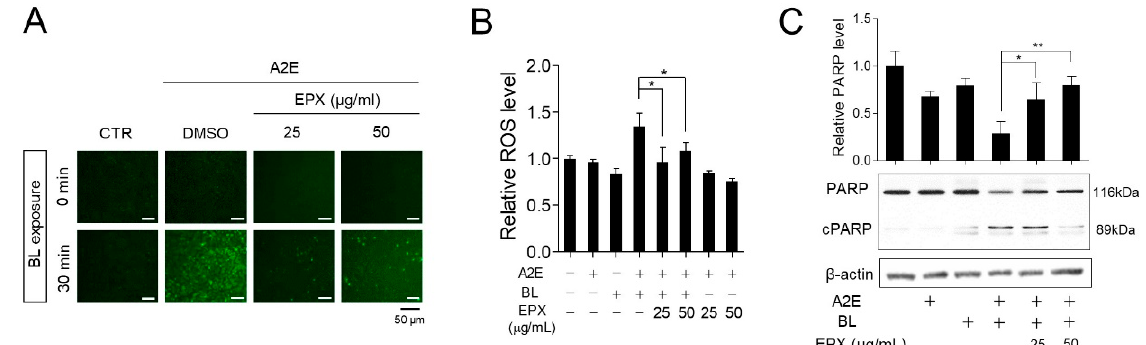
Figure 3. EPX decreases ROS production and apoptosis induced by blue light in A2E-laden retinal pigment epithelium (RPE) cells. ( A , B ) Decrease in ROS production by EPX. After treatment with EPX (25–50 µ g/mL), ROS level was monitored by DCFH-DA (10 µ M, 10 min) in blue light (BL)-exposed A2E-laden RPE cells. The fluorescence was visualized by fluorescence microscopy ( A ) and quantified using a fluorescence microplate reader ( B ). CTR—control; DMSO—dimethyl sulfoxide; BL—blue light; + —sample treatment; ROS—reactive oxygen species. The results are presented as the mean ± S.D. ( n = 4); * p < 0.05. ( C ) Reduction of PARP cleavage by EPX. A2E-laden RPE cells were treated with EPX (25–50 µ g/mL) for 48 h before BL illumination. Western immunoblot analysis indicated full-length PARP and cleaved PARP (cPARP) protein expression, and the band intensities were quantified by densitometric analysis. cPARP—cleaved PARP. The results are presented as mean ± S.D. ( n = 3); * p < 0.05; ** p < 0.01.